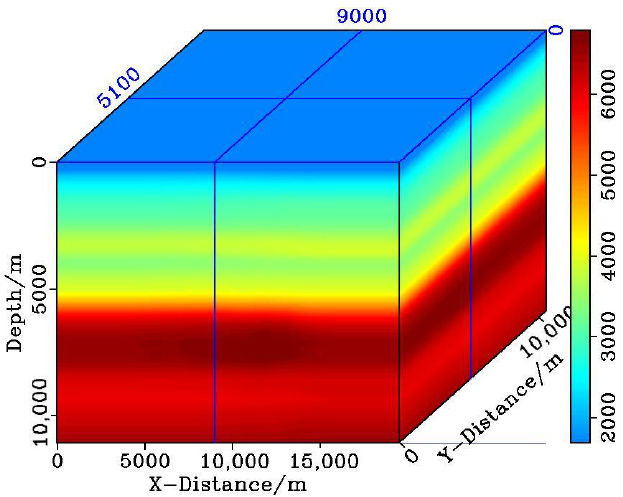
Figure 8. Migration velocity for Tarim oil